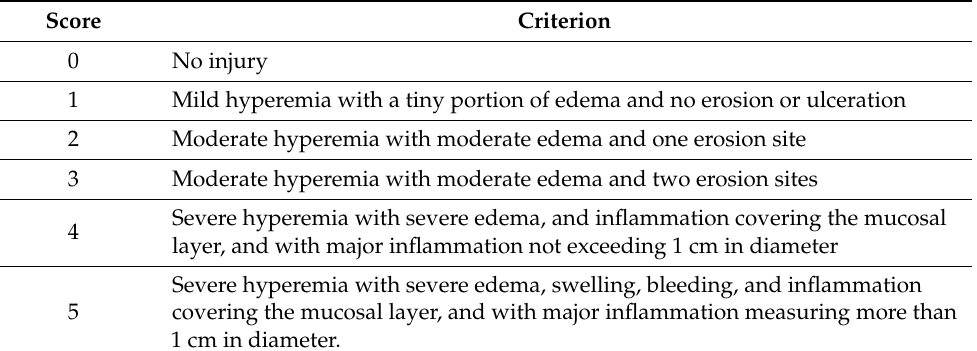
Table 1. Colon mucosal injury scoring